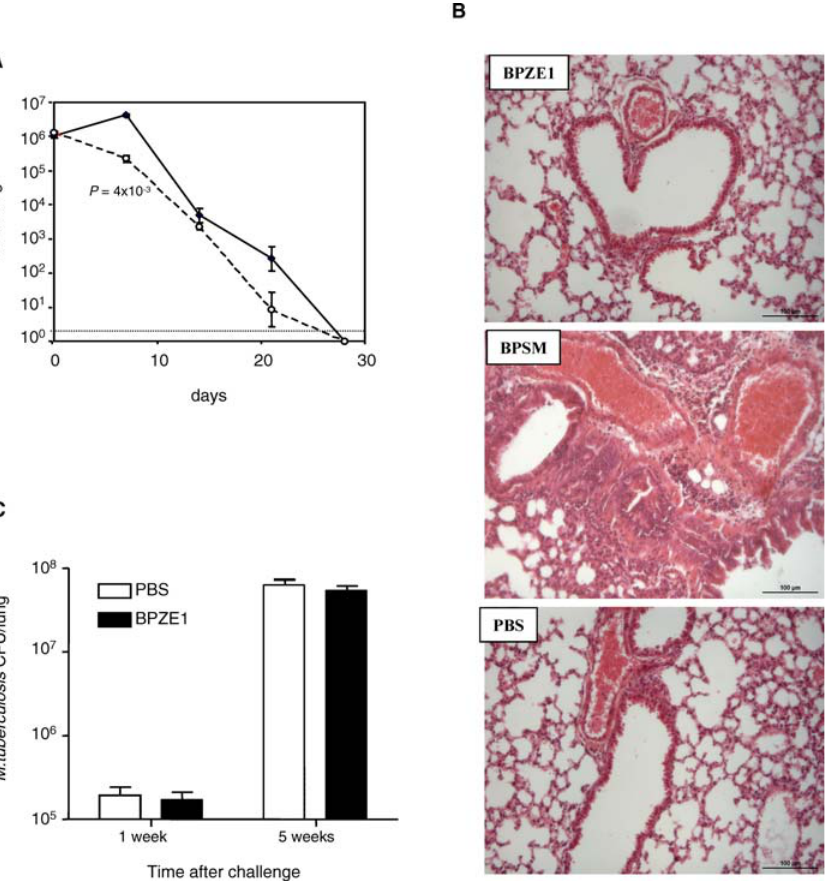
Figure 3. In Vivo Characterization of B. pertussis BPZE1 (A) Lung colonization by BPSM (solid lines) and BPZE1 (dotted lines) of adult mice infected intranasally with 10 6 CFU of BPZE1 or BPSM. The results are expressed as mean ( 6 standard error) CFUs from three to four mice per group, and are representative of two separate experiments. The dashed line represents the limit of bacterial counts. (B) Histological analysis of lungs from BPZE1 (upper panel) or BPSM-infected (middle panel) adult mice compared to controls given PBS (lower panel). One week after infection, the lungs were aseptically removed and fixed in formaldehyde. Sections were stained with hematoxylin and eosin, and examined by light microscopy. (C) Susceptibility of BPZE1-infected mice to infection by M. tuberculosis . Balb/C mice were infected intranasally with 10 6 CFU of BPZE1 (filled columns) or received PBS (open columns) and were intranasally infected one week later with 5 3 10 4 M. tuberculosis H37Rv. One week (left columns) and 5 wk (right columns) after M. tuberculosis infection, the M. tuberculosis CFUs present in the lungs were counted. The results are expressed as mean ( 6 standard error) CFUs from four mice per